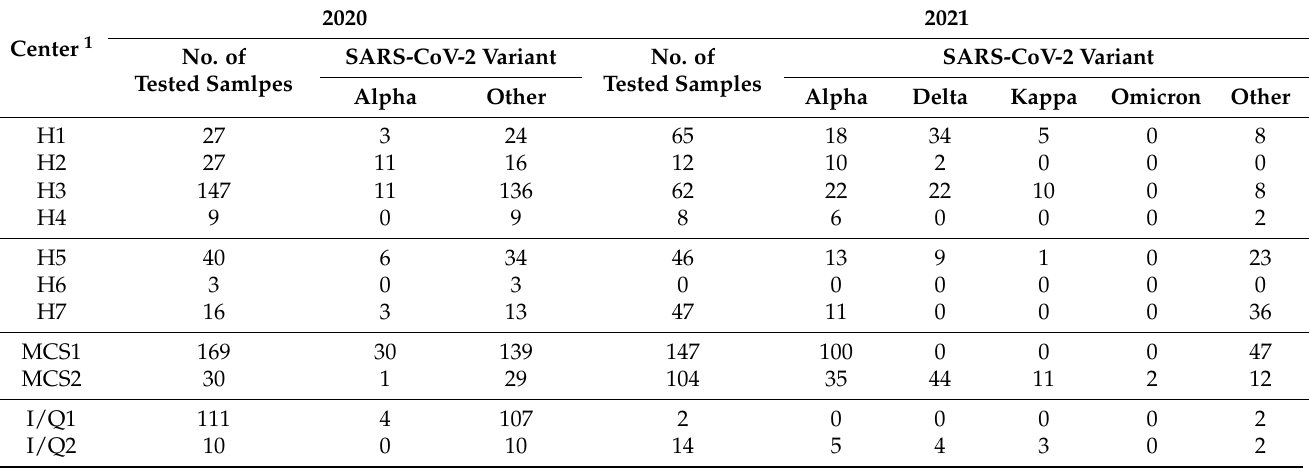
Table 3. SARS-CoV-2 variants in each center with the numbers of their samples in 2020 and